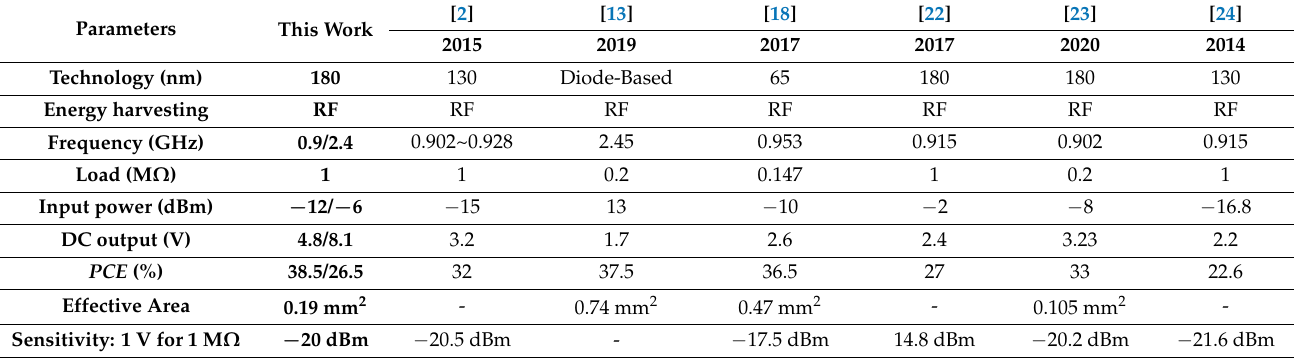
Table 1. Summary and performance comparison. Parameters